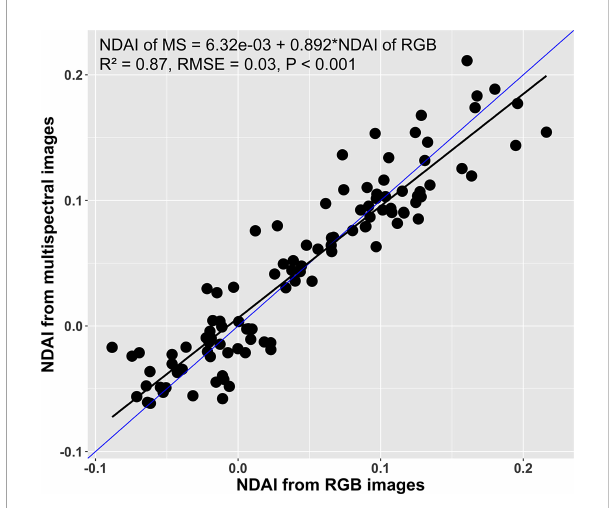
FIGURE 8 Correlation between canopy normalized difference anthocyanin index (NDAI) derived from multispectral and RGB images (n = 108). The black line is the regression line, while the blue line is a 1:1 relation